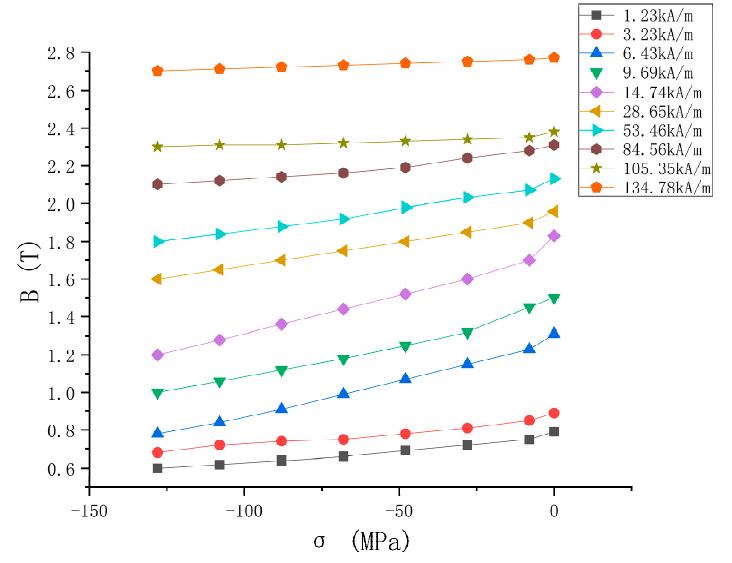
Figure 4. Relationship between magnetic induction intensity and compressive stress under different bias magnetic fields.